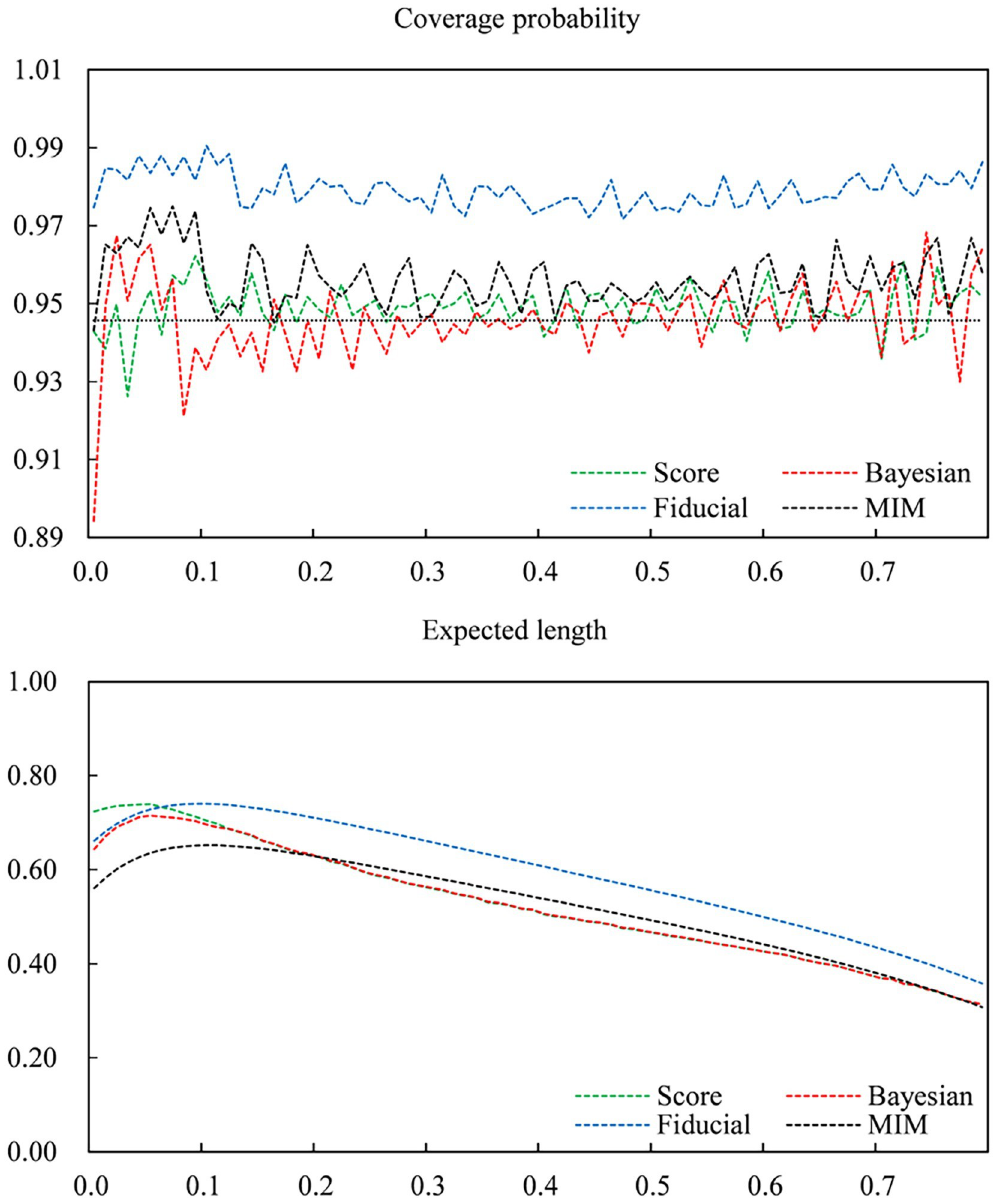
Fig 2. Coverage probabilities and expected lengths of the Score, Bayes, fiducial and MIM confidence intervals versus P 12 for fixed P 11 , where n = 30 and P 11 =